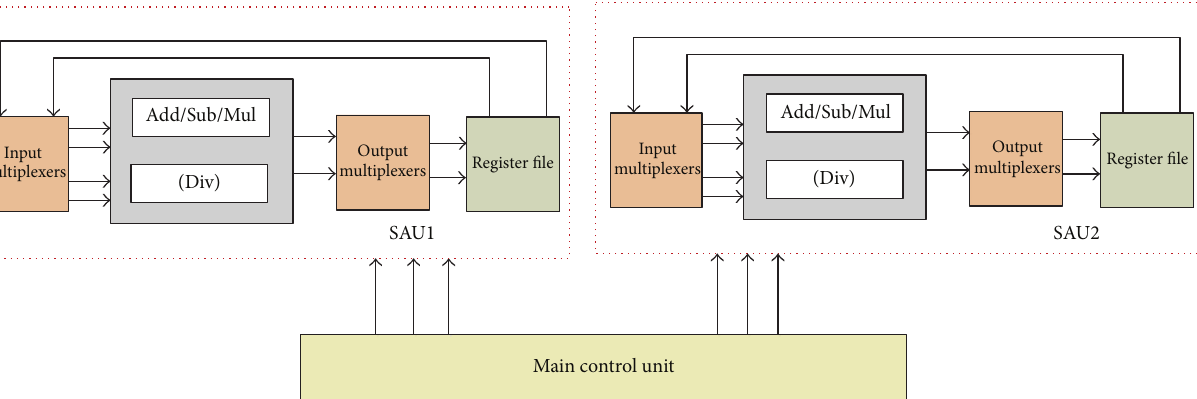
Figure 3: Proposed EC scalar multiplier architecture.